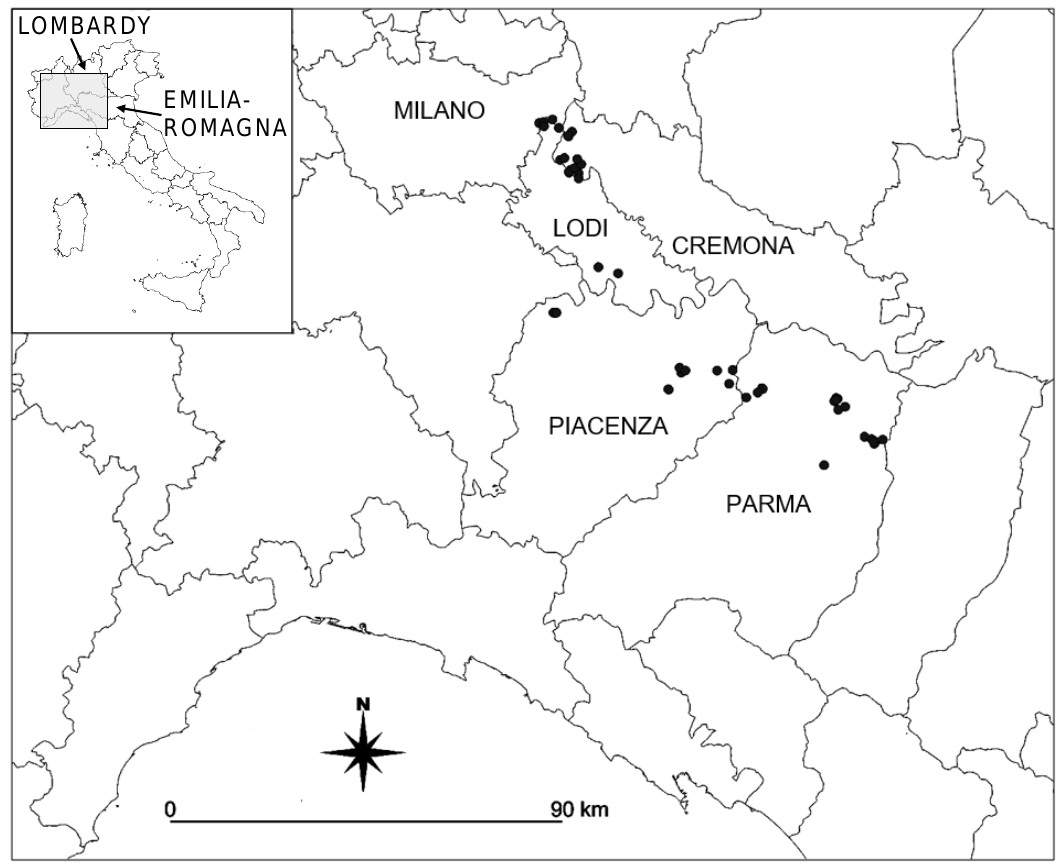
Figure 1. Upper left panel: map of Italy in which the Lombardy and Emilia-Romagna regions are indicated, as well as the grey area corresponding to the main panel. Main panel: location of sampling sites (black dots) in the provinces of Parma and Piacenza (Emilia-Romagna) and Lodi, Cremona and Milano (Lombardy).